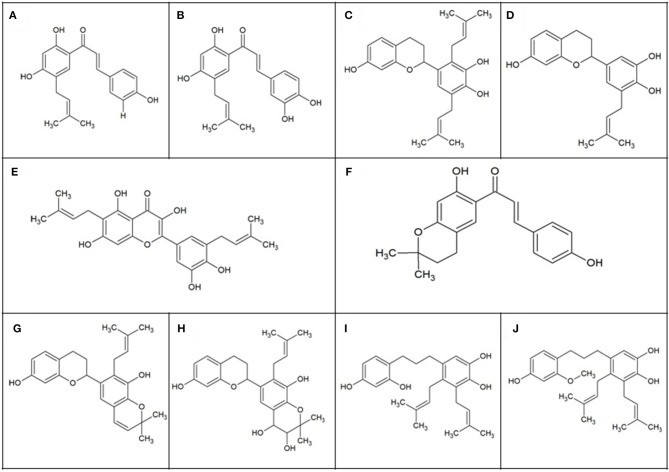
Polyphenols isolated from Brussonetia papyrifera. (A) Broussochalcone B (C20H20O4); (B) broussochalcone A (C20H20O5); (C) kazinol A (C25H30O4); (D) 3'-(3-methylbut-2-enyl)-3',4,7-trihydroxyflavone (C20H22O4); (E) papyriflavonol A (C25H26O7); (F) 4-hydroxyisolonchocarpin (C20H20O4); (G) kazinol B (C25H28O4); (H) broussoflavan A (C25H30O6); (I) kazinol F (C25H32O4); (J) kazinol J (C26H34O4).